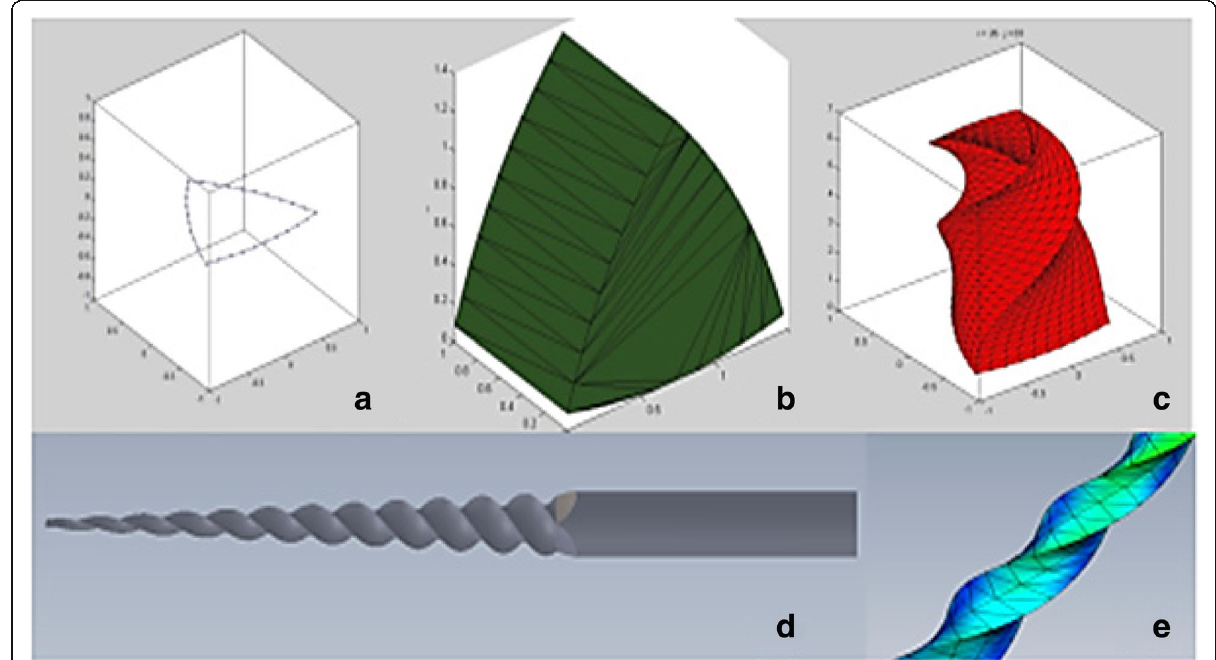
Fig. 1 a 2D drawing of HyFlex file cross section in SolidWorks software. b , c The building of the 3D model of HyFlex file in MATLAB software. d 3D models of HyFlex file. e Meshing of the FE models of HyFlex